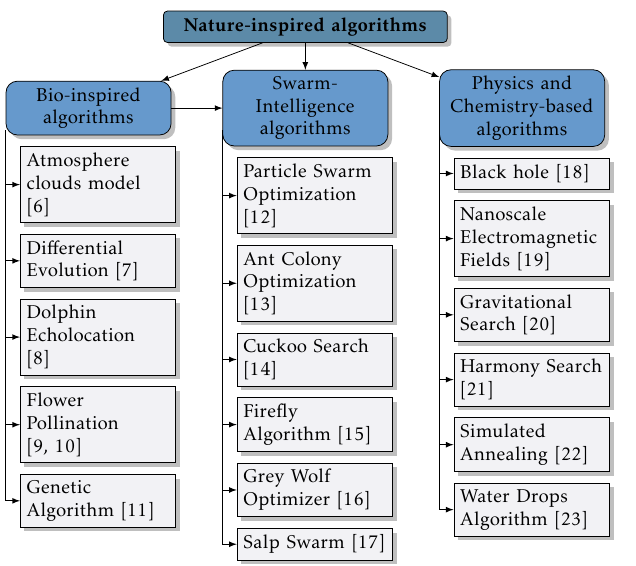
Figure 1. Nature-inspired algorithms classification and examples sources of inspiration for this category of algorithms are electromagnetic fields, gravity processes, etc.